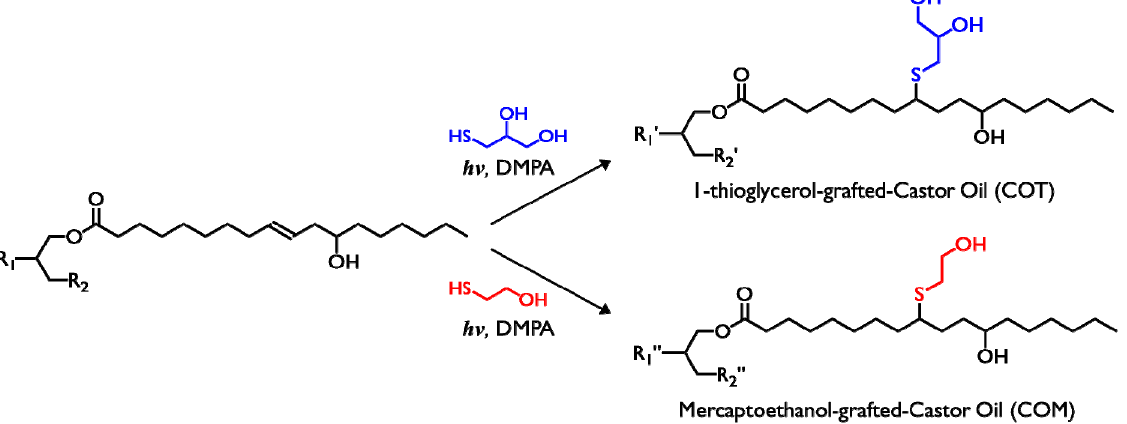
Scheme 1. Preparation of castor oil-based multifunctional polyols by the thiol-ene photo-click reaction.